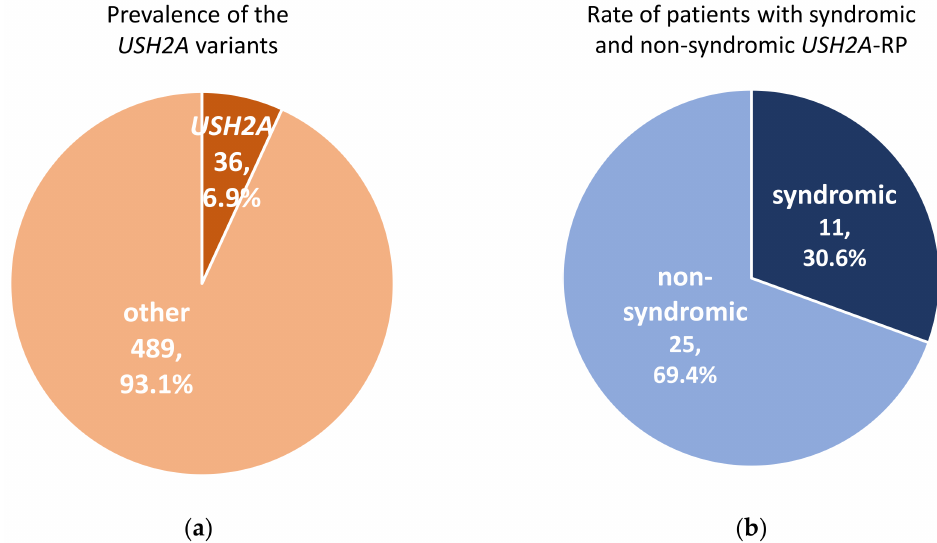
Figure 1. Prevalence of pathogenic variants in USH2A and rate of syndromic and non-syndromic USH2A -retinisis pigmentosa (RP) patients. ( a ) Pathogenic USH2A variants were detected in 36 of 525 RP cases. ( b ) There were 11 syndromic and 25 non-syndromic USH2A -RP patients in this